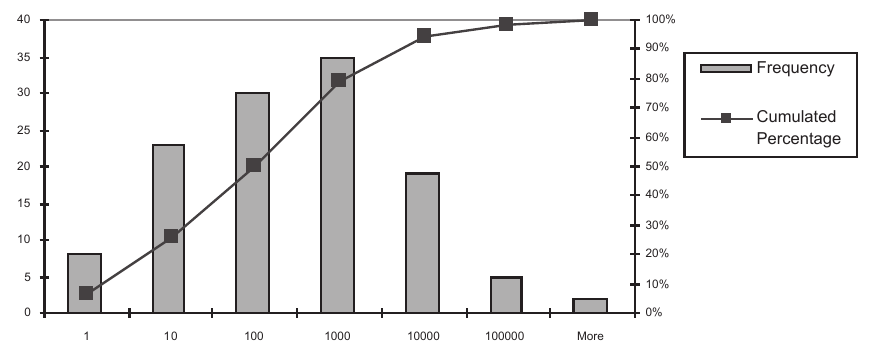
Fig. 3. – Prevalence of E. multilocularis along the increasing gradient of urba- nization (represented with 95 % Confi- dence interval).